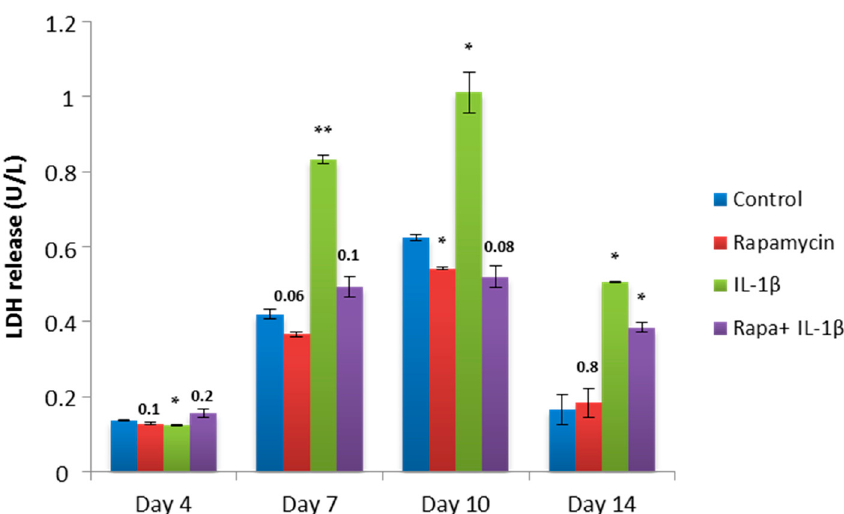
Figure 4. Lactate dehydrogenase (LDH) release of chondrocyte pellets cultured in an OA-model. Patient-derived OA chondrocyte pellets were cultured in media supplemented with or without rapamycin, the inflammatory cytokine interleukin (IL)-1 β or rapamycin in combination with IL-1 β for 14 days. Chondrocyte pellets cultured with culture media alone are indicated as control. Supernatants were collected on indicated time points and released LDH was measured. Experiments were performed in triplicates and results are shown as mean ± SEM versus control. p < 0.05 was considered significant (*) and p < 0.01 was considered highly significant (**). Exact values were given when p > 0.05.